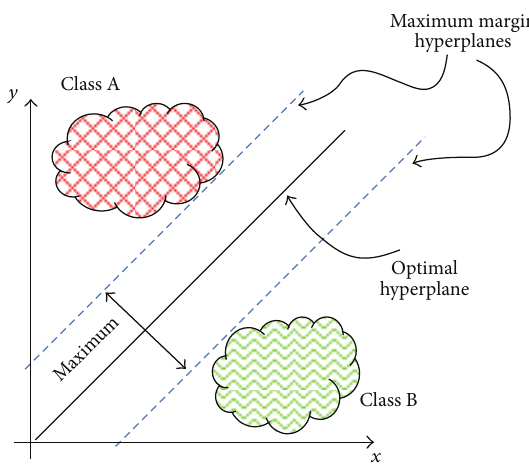
Figure 3: Linearly separable classification; hyperplane and separa- tion